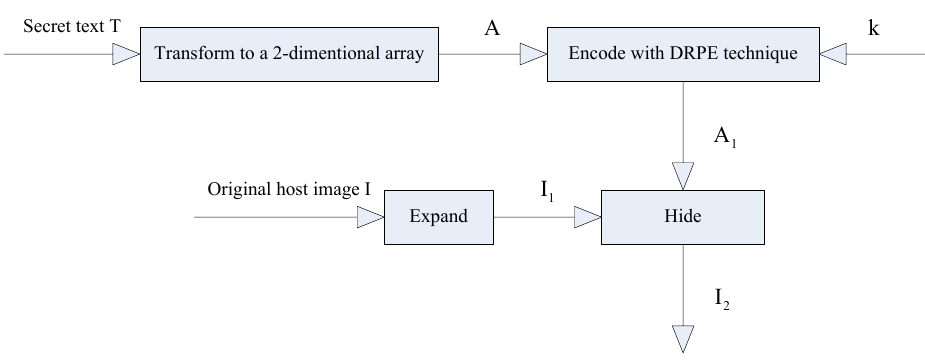
Figure 1. Encoding and hiding